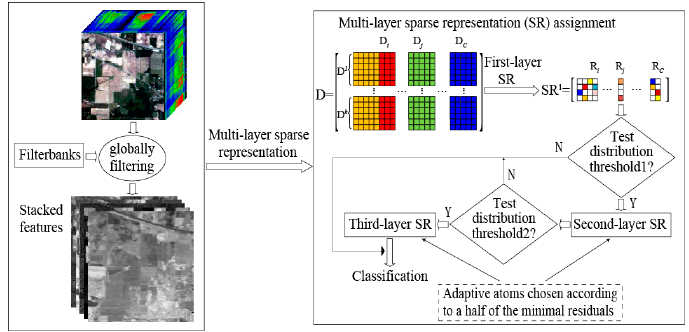
Figure 3. Overall architecture of the proposed multi-layer spatial-spectral sparse representation (mlSR) framework.